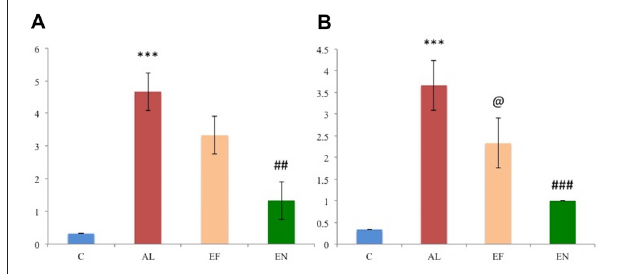
FIGURE 5 | Scoring of the immunohistochemical images in the (A) cortex and (B) hippocampus regions of the rat brain ( n = 3). Abbreviations: C, control; AL, AlCl 3 induced Alzheimeric rats; EF, free EGCG treated AlCl 3 induced Alzheimeric rats; EN, nanoEGCG treated AlCl 3 induced Alzheimeric rats. Significance difference between groups indicated by: ∗ between C and AL, @ between AL and EF and # between AL and EN. Significance levels of p < 0.001, p < 0.01 or p < 0.05 are denoted by repetition of these symbols.